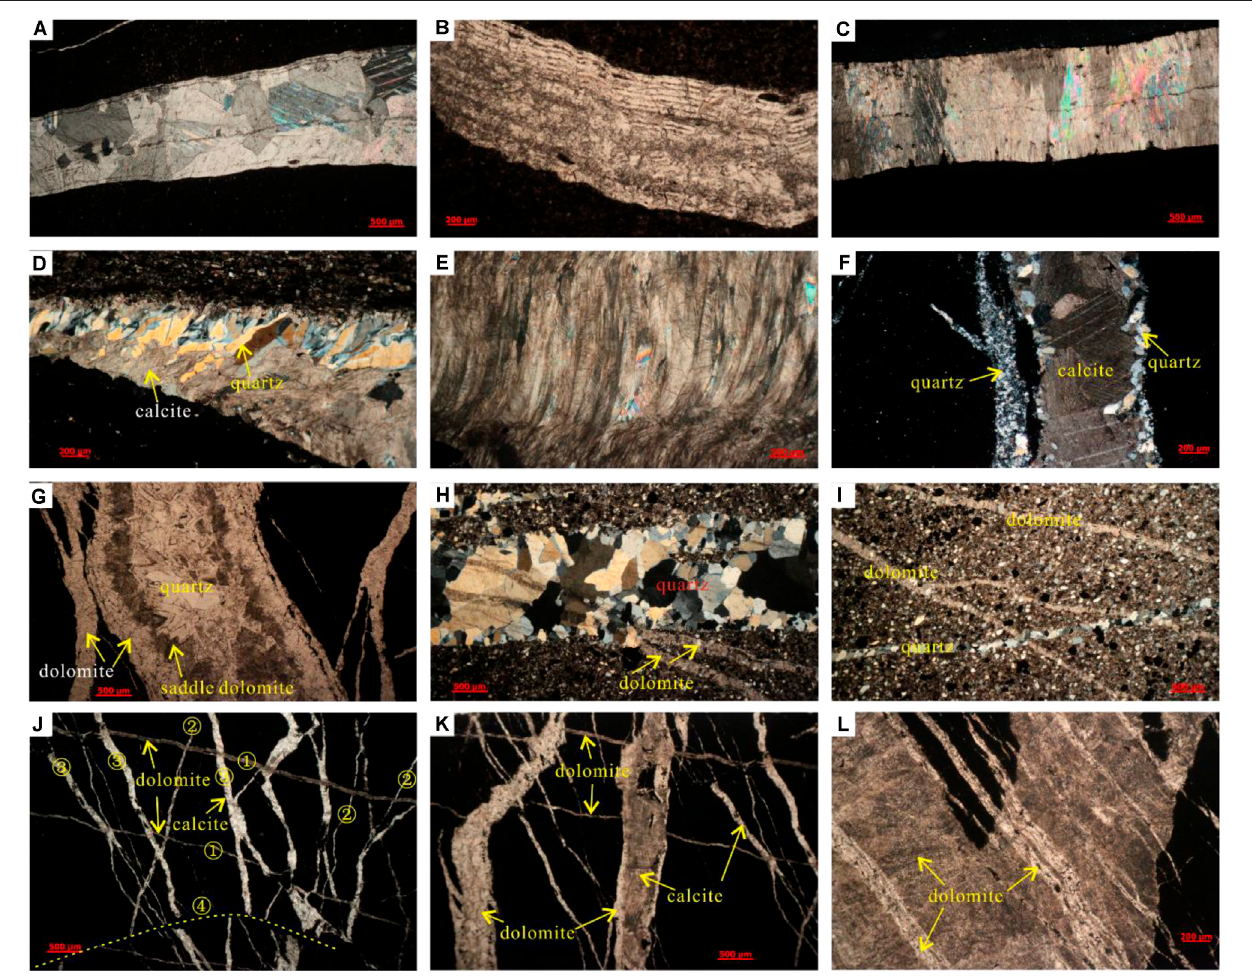
FIGURE 7 | Micrographs of the fracture fi llers of Niutitang shale. (A) 1926.53 m, syntaxial blocky calcite vein, the calcite vein with better crystal status has the characteristics of multistage growth, orthogonal light; (B) 1929.77 m, calcite- fi lled fracture, the calcite vein with poor crystal status has the characteristics of multistage growth,plainlight; (C) 1999.76 m,syntaxialstretchingcalciteveinwiththecharacteristicsofmultistagegrowth,orthogonallight; (D) 1990.46 m,antitaxial fi brouscalcite- and quartz- fi lled fracture with the competitive growth of calcite and quartz, orthogonal light; (E) 2003.94 m, antitaxial fi brous calcite- fi lled fracture, the bending of the fi bers was formed by progressive deformation of the crystal growth, orthogonal light; (F) 2024.05 m, fractures were fi rst fi lled with calcite and later converted by hydrothermal quartz, orthogonal light; (G) 2029.8 m, fractures were fi rst fi lled with calcite and later converted by hydrothermal quartz. The dolomite in contact with the quartzhasthetypicalcharacteristicsofsaddledolomite,plainlight; (H,I) 1987.52 m,thequartz- fi lledfracturesformedintheearlystageandthelaterformedthedolomite- fi lledfractures, orthogonallight; (J,K) 2026.81 m,therearefourstagesoffractures,followedbydolomite- fi lledlowdip-anglefractures,dolomite- fi lledordolomite/calcite fi lled rightward dipping fractures, calcite- fi lled leftward dipping fractures and slip fractures, plainlight; (L) 2029.8 m, two stages of dolomite- fi lled fractures, plainlight.